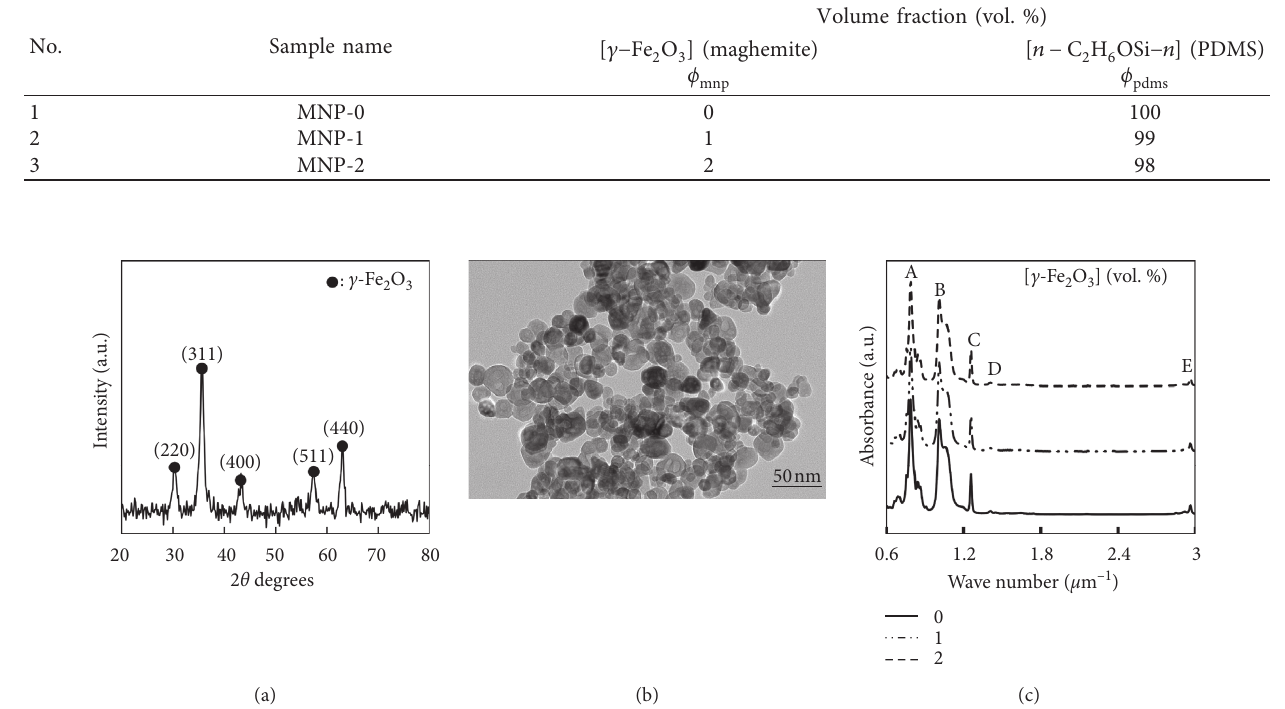
O at a power of 45kV × 40mA. (b) Transmission 2 3